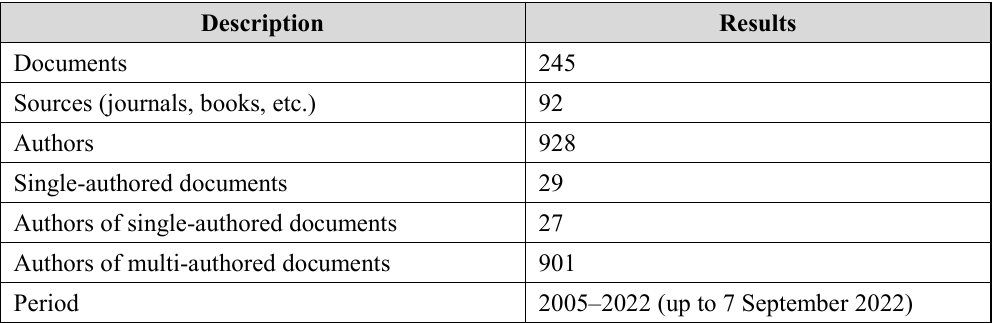
Table 1. The Main Information on the